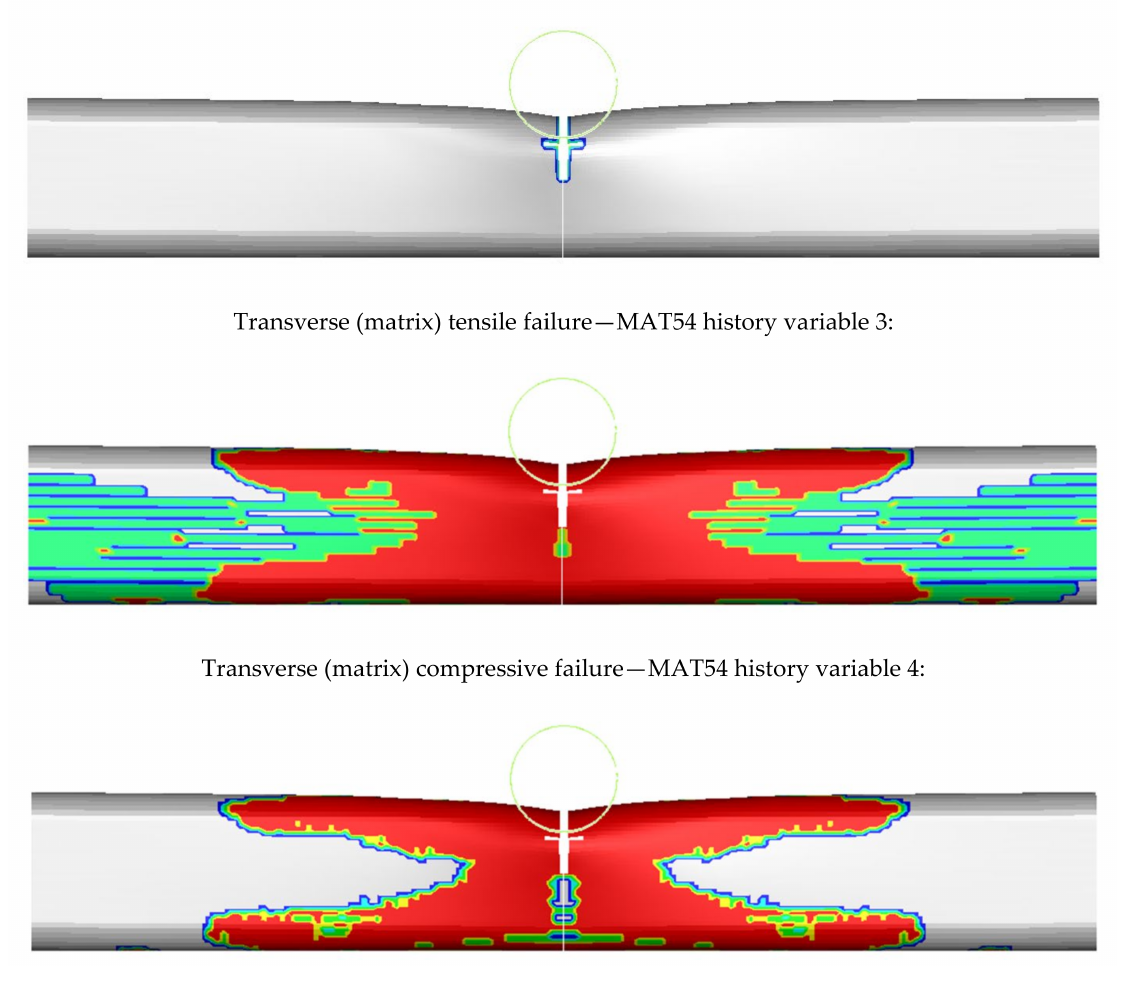
Figure 8. Visual and predicted (MAT54) damage in the outer layer of the [0 4 , 90 3 ] S specimen (color scheme: gray—not damaged, red—fully damaged; indenter shown for scale representation